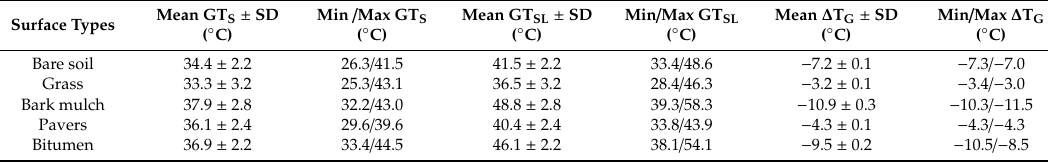
Table 4. Mean, minimum and maximum shaded globe temperature (GT S ), sunlit globe temperature (GT SL ), and globe temperature di ff erential ( ∆ T G ) recorded over bare soil, grass, bark mulch, concrete pavers and